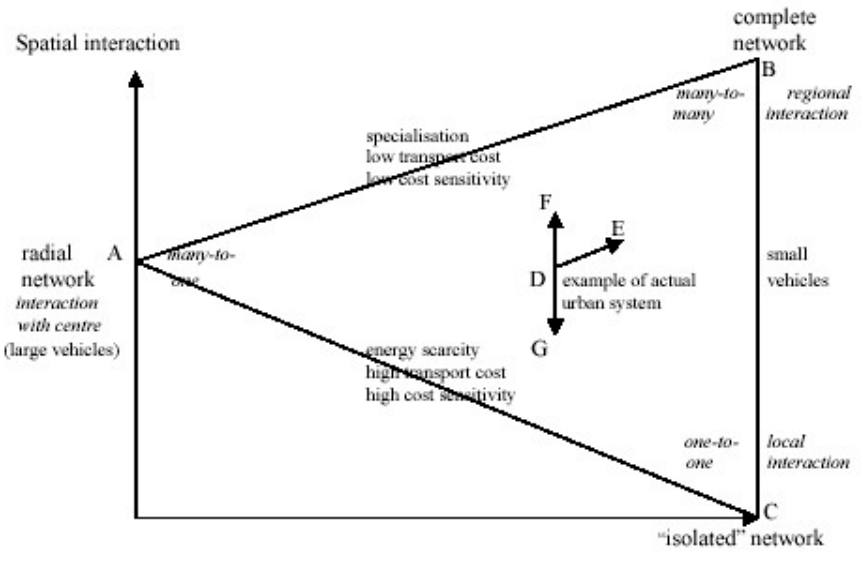
Figure 2. Main features of the “Brotchie triangle” on land-use and travel behaviour. For a more complete original figure and discussion, see Brotchie